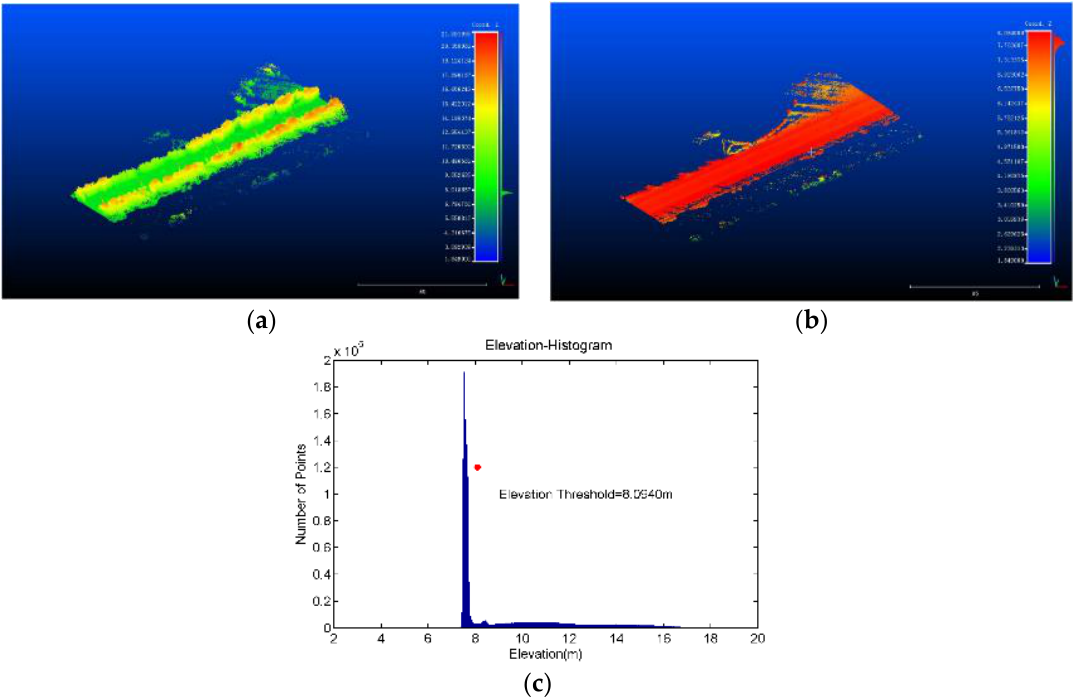
Figure 5. A sample of elevation filtering: ( a ) point clouds before elevation filtering (coloured by elevation); ( b ) point clouds after elevation filtering (coloured by elevation); and ( c ) elevation histogram.